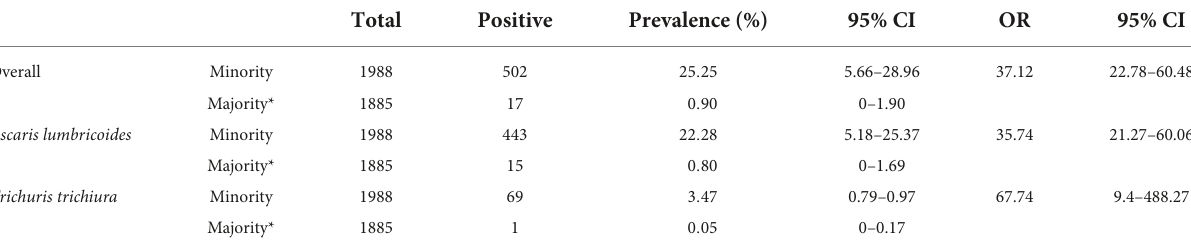
TABLE 1 Soil-transmitted helminths (STH) prevalence in the population of Eastern Slovakia (Košice and Prešov regions) categorized by minority or majority status.